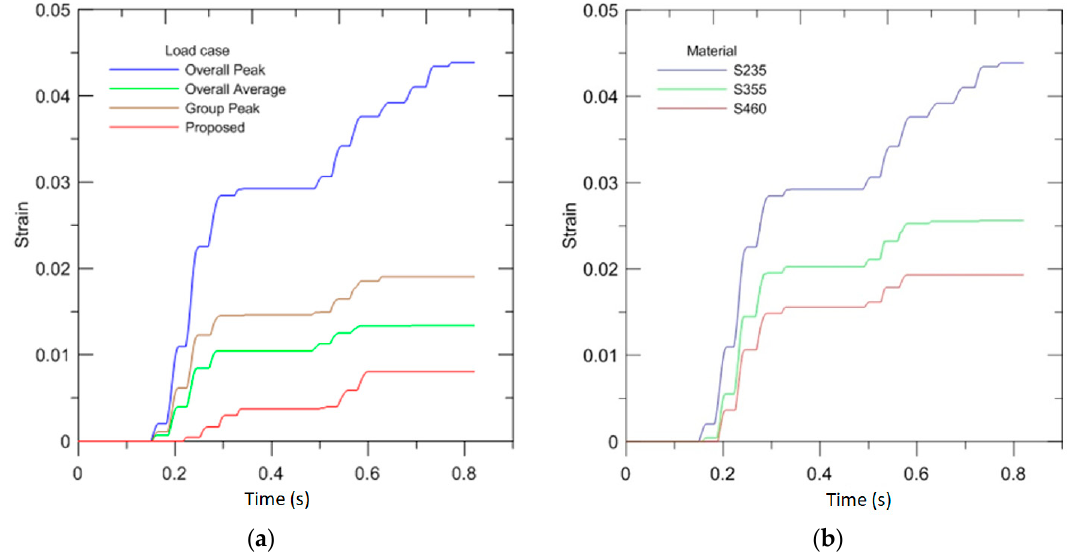
Figure 19. Strain profile of ( a ) frame S235 for each load case and ( b ) frame for load case-1 according to the material.